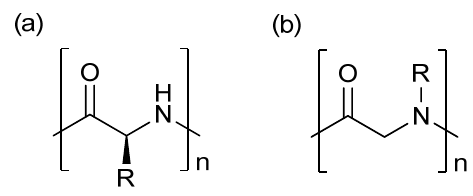
Figure 1. Structures of ( a ) peptide; ( b )